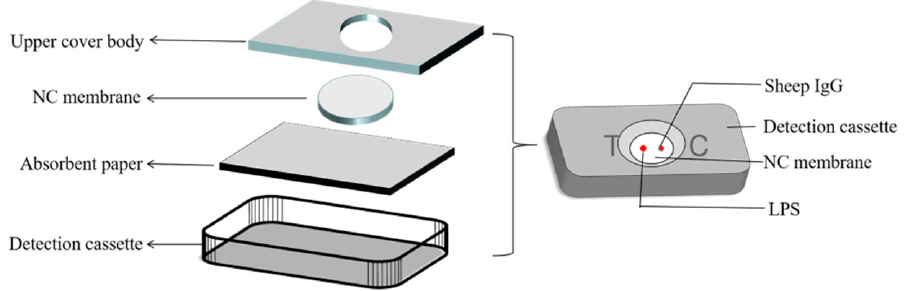
Figure 1. Structure diagram of the test box.